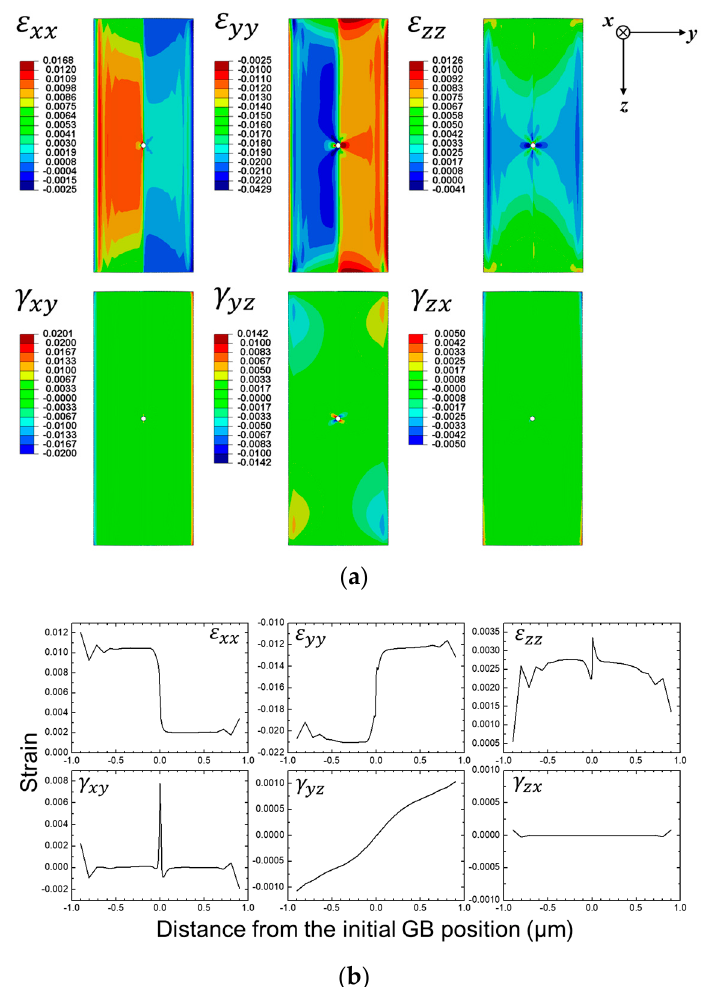
Figure 3. ( a ) Strain maps for the normal and shear components and ( b ) corresponding plots. Reprinted from Ref. 4 with permission; Copyright Springer 2019.